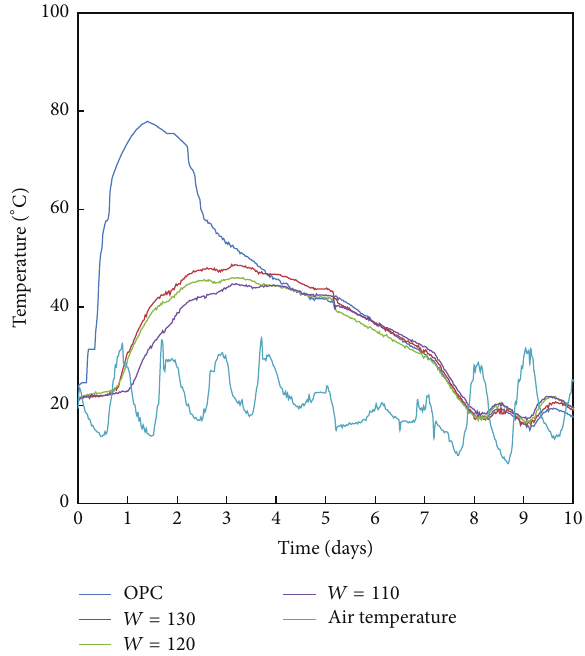
Figure 7: The heat of hydration of high volume fly ash HFC in field.